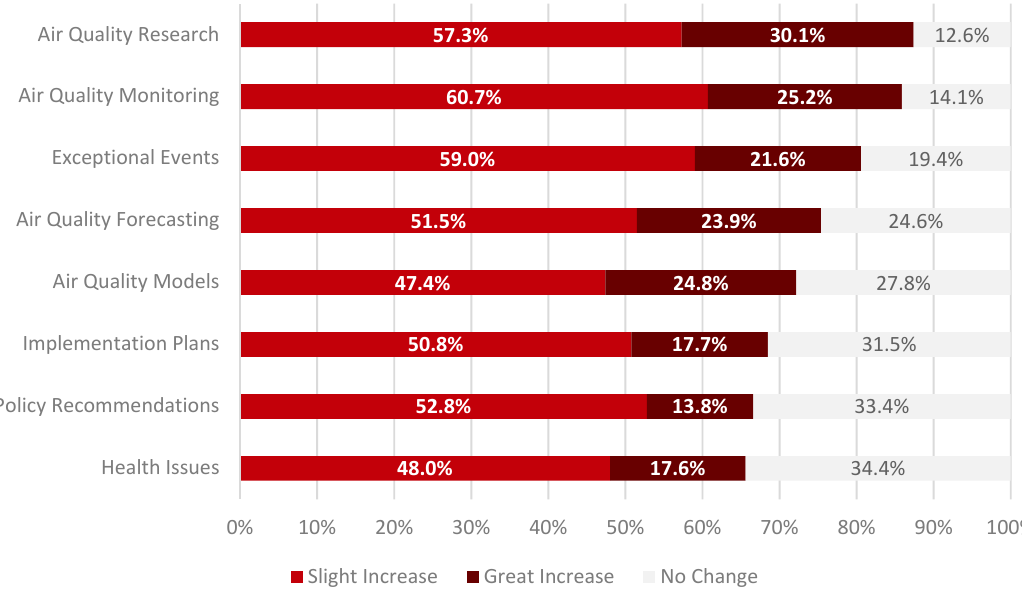
Figure 7. Change in use of RSD as a result of ARSET for air quality research and applications. Light red = slight increase; dark red = great increase; gray = participants for whom the task was applicable, but who indicated “no change” in their use of RSD for that task ( N = 122–143 with 6–25 claiming that the task was not applicable).